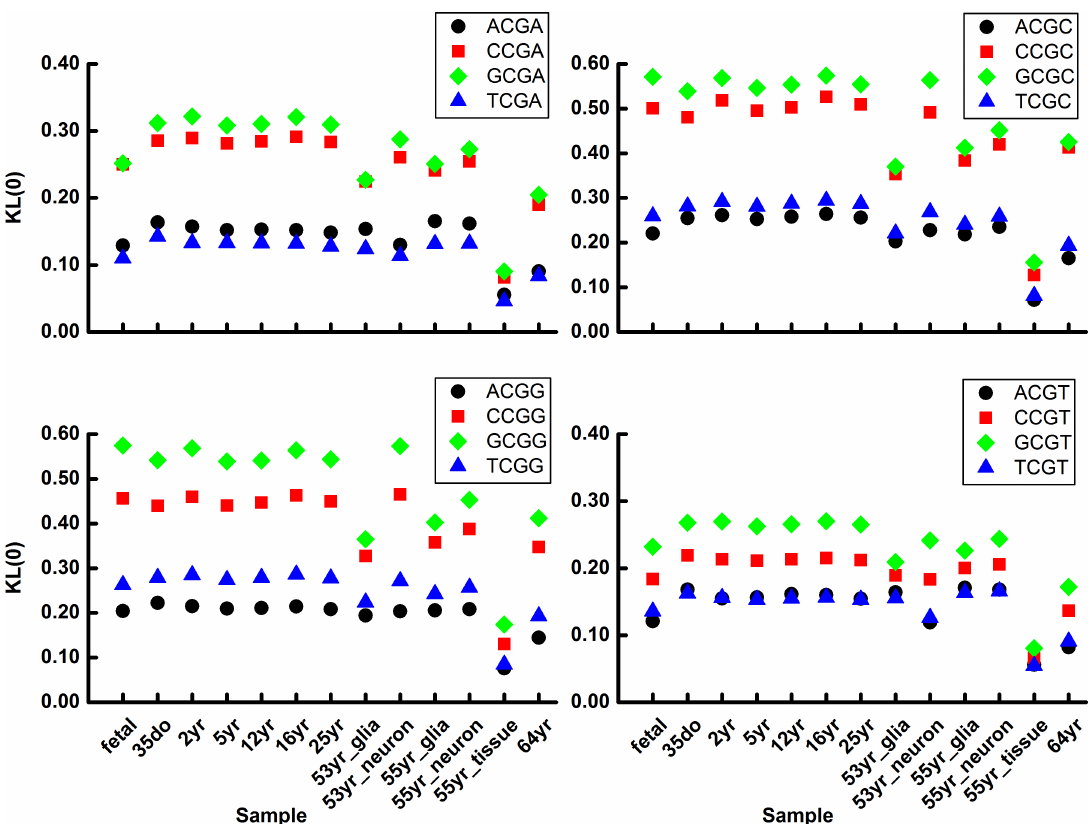
Fig 2. Methylation variation of N 5 CGA (upper left), N 5 CGC (upper right), N 5 CGG (lower left) and N 5 CGT (lower right) of chromosome 1 in human brain cells. The KL (0) of ACGN 3 , CCGN 3 , GCGN 3 and TCGN 3 are representedas black circle, red square, green diamondand blue triangle, respectively. N 5 , N 3 = A, C, G or